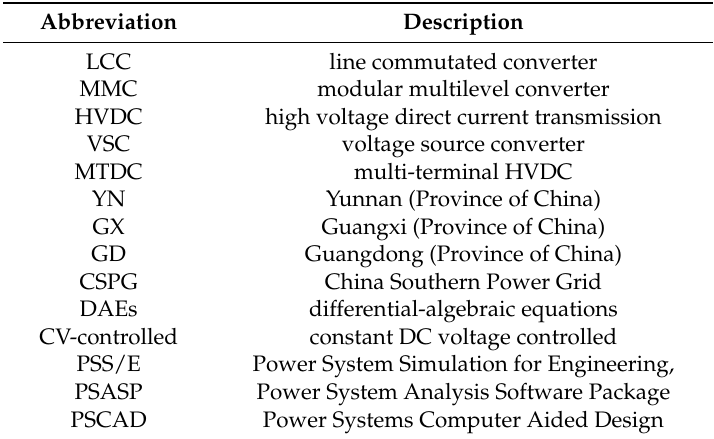
Table A3. Summarization of the